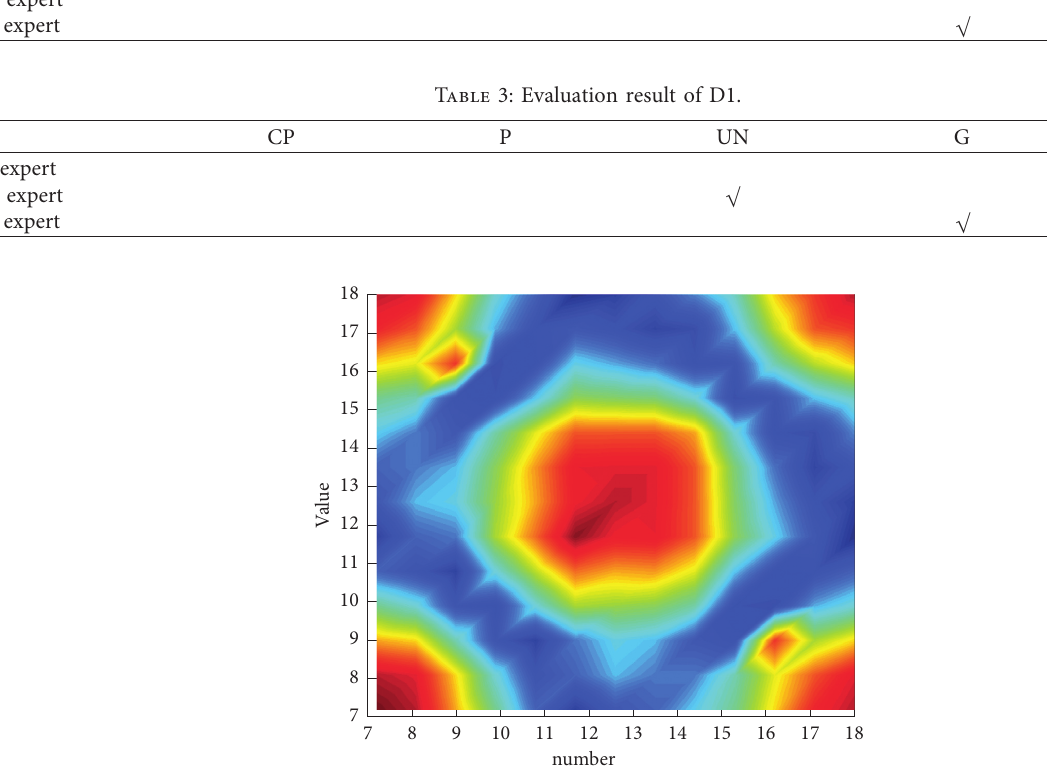
Figure 7: Value vs.